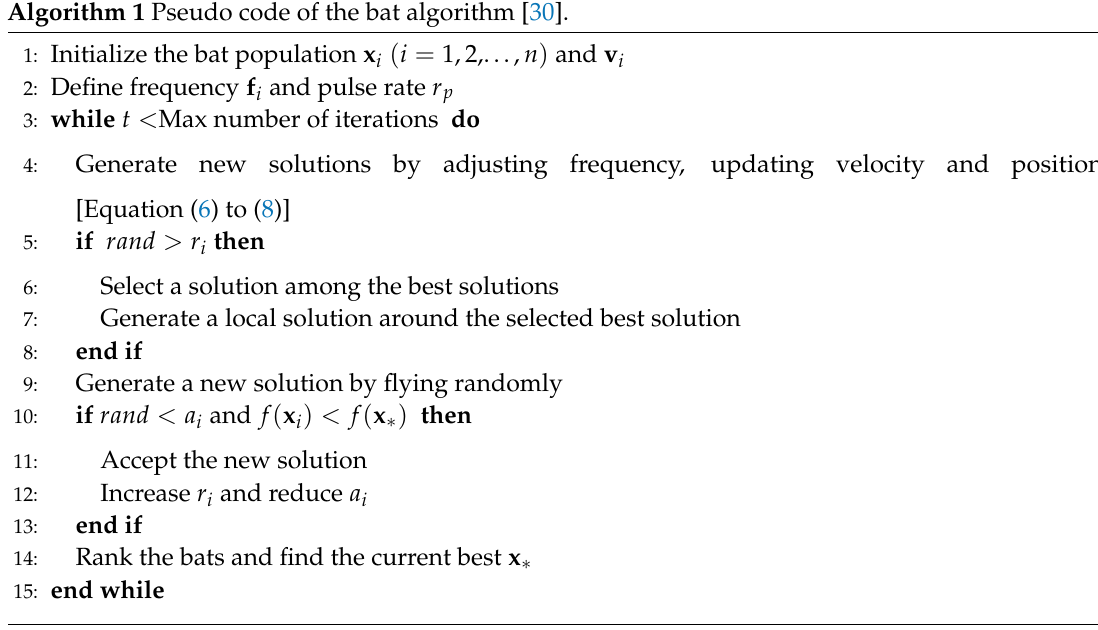
Algorithm 1 Pseudo code of the bat algorithm